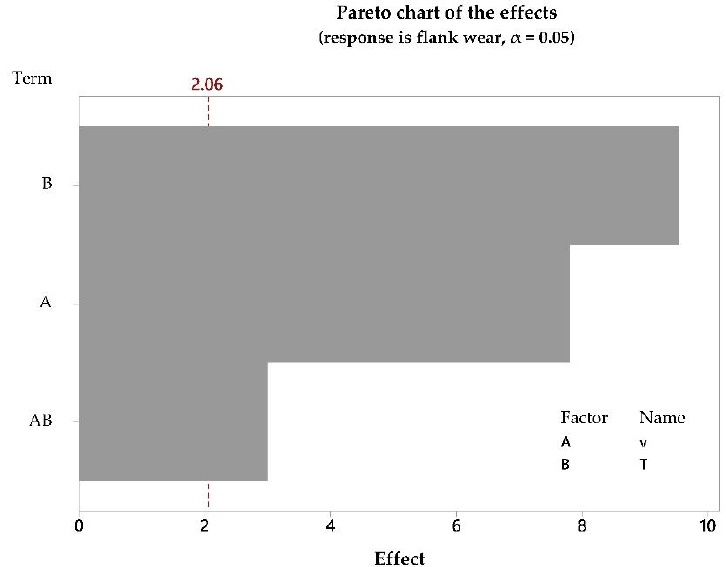
Figure 3. Pareto graphic of variable effects on flank wear, for the CT5015-P10 insert.